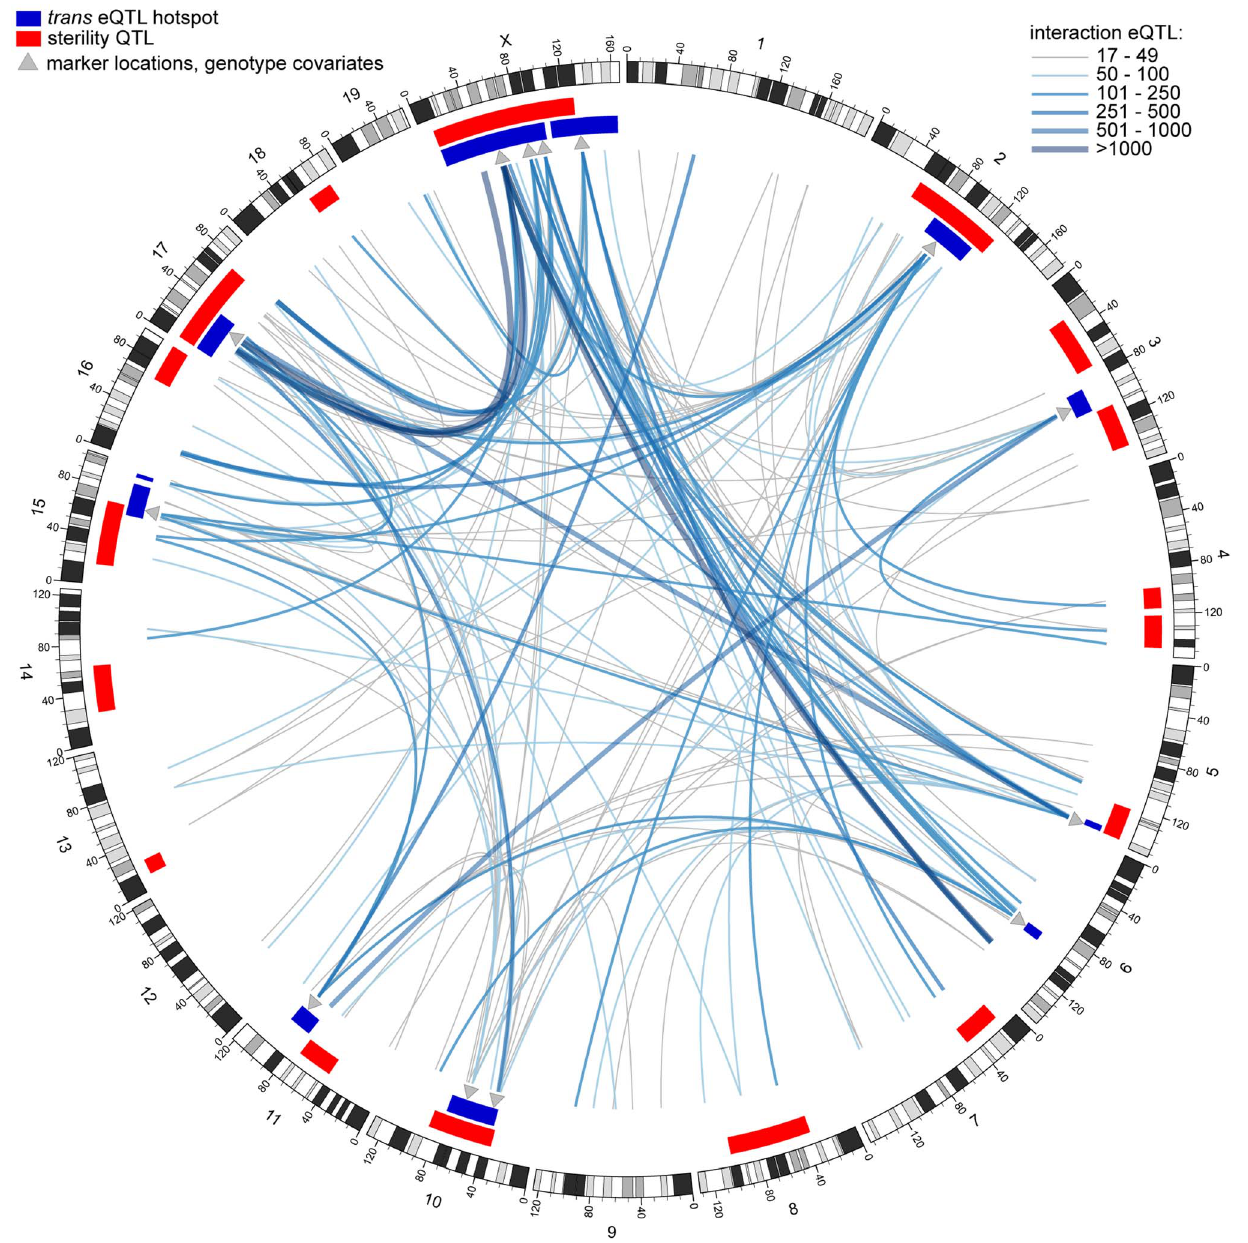
Figure 4. Genetic interactions revealed by conditional mapping. Genome plot generated using circos software [106]. Each line represents an interaction eQTL hotspot; color and thickness indicate number of eQTL. Red rectangles indicate sterility QTL positions and dark blue rectangles indicate trans eQTL hotspots (original mapping). Grey triangles indicate positions of marker genotypes used as covariates in conditional mapping.